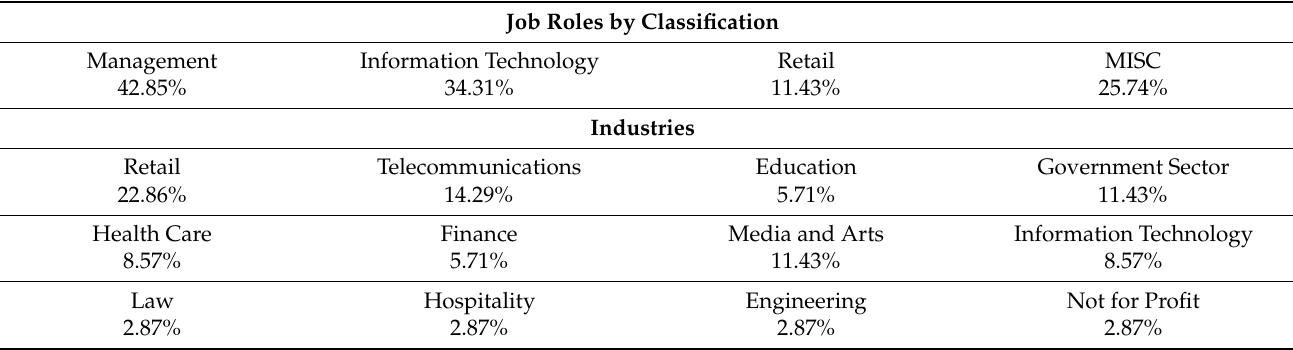
Table 4. Organisations’ parent industries and respondents’ job role